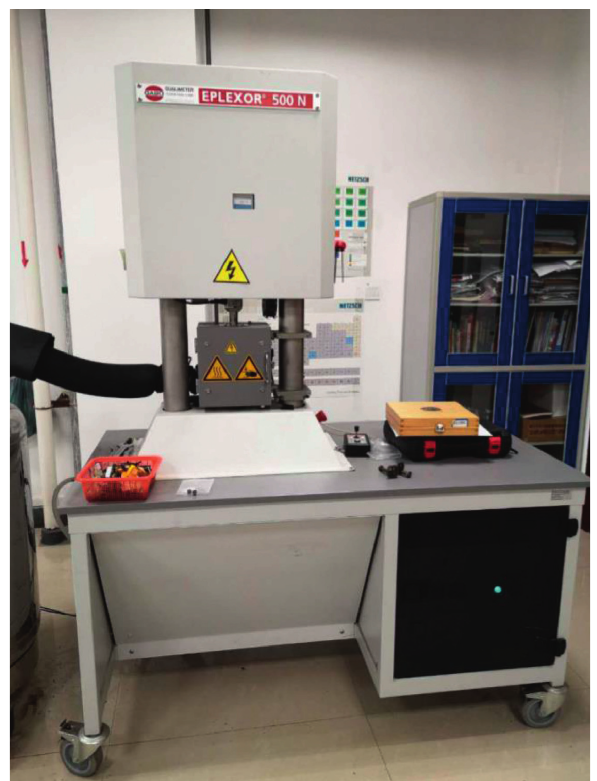
Figure 6: Dynamic thermomechanical analyzer.